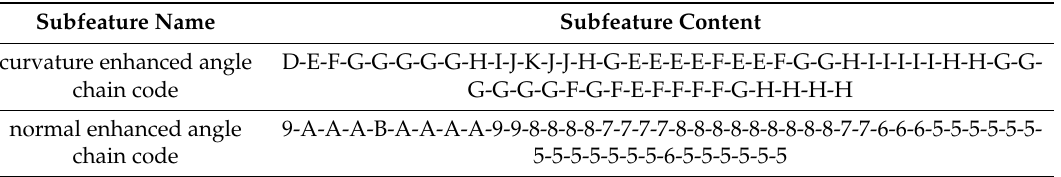
Figure 12. Storage method of skyline. Use a list ( right ) to record the skyline data and the length of the list is the width of the photo ( left ). List the index of each element according to its corresponding position on the image, and the position of each element is the height of the point on the image. Table 2. The Enhanced Angle Chain Code (2°-order) of the skyline in Figure 12.